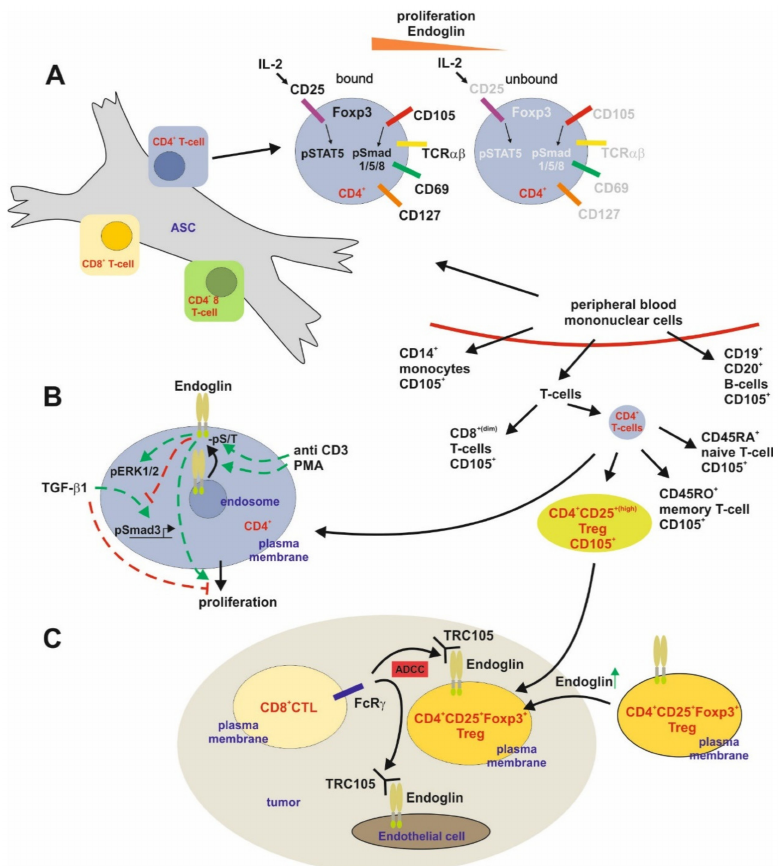
Figure 6. Endoglin expression and function in T cells. ( A ) Adipose tissue derived stem cells (ASC) are able to regulate T-cell dependent immune responses in part by sequestering reactive CD4 + T-cells. Allo-activated CD4 + T cells tightly bound to ASC show a higher CD25 expression and in turn IL-2-dependent STAT5 activation. These cells present a higher proliferation and increased Endoglin (Eng) expression along with a higher Smad1 / 5 / 8 phosphorylation (activation). Nevertheless, aside the higher Foxp3 expression, the bound cells also had a higher CD127 expression excluding that they are Tregs. ( B ) High expression of Eng is present in CD4 + T-cells isolated from peripheral blood. TCR / pathway activation of these CD4 + T-cells by CD3 or PMA leads to a higher surface expression of Eng and increased serine / threonine phosphorylation of the receptor. Activation of Eng induces ERK1 / 2 phosphorylation and higher proliferation. On the other hand, Eng interferes with TGF- β 1-mediated Smad signaling and inhibition of proliferation. ( C ) In the setting of tumorigenesis, intratumoral CD4 + T-cells, i.e., CD25 + / Foxp3 + Tregs, express higher Eng compared to their circulating counterparts. This causes an antibody-dependent cellular cytotoxicity (ADCC) resulting in reduction of intratumoral Tregs (immunosuppressive) upon application of TRC105 via CD8 +